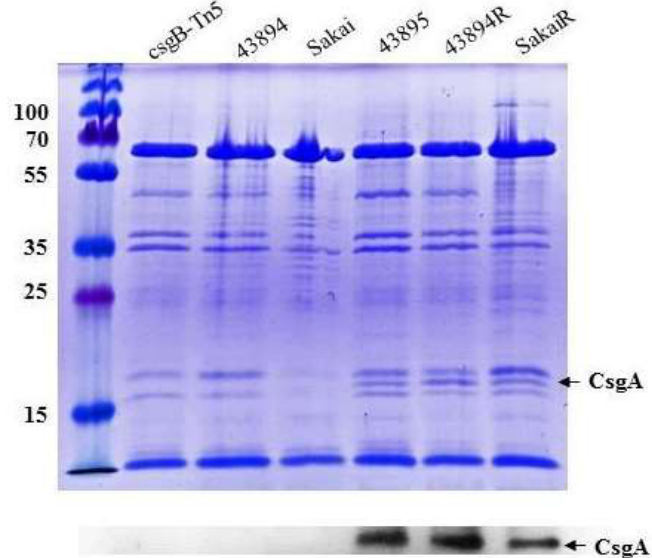
Figure 4. Curli fimbriae were expressed in O157 invasive strains but not in non-invasive strains. Bacterial strains were grown overnight in LB broth at 37 °C without aeration. To detect the major subunit of curli fimbriae CsgA, cell surface fibers were sheared by vortexing, concentrated by ultra-centrifugation, depolymerized with formic acid, and separated by SDS-PAGE. Proteins were visualized by Coomassie blue straining or transferred to membranes for immunoblotting. The predicted CsgA 17-kDa protein is seen only in 43895, 43894R, and SakaiR (CsgA arrow; molecular weight standards and kDa values are at left). The CsgA identification is confirmed by immunoblot with anti-CsgA sera (CsgA arrow).